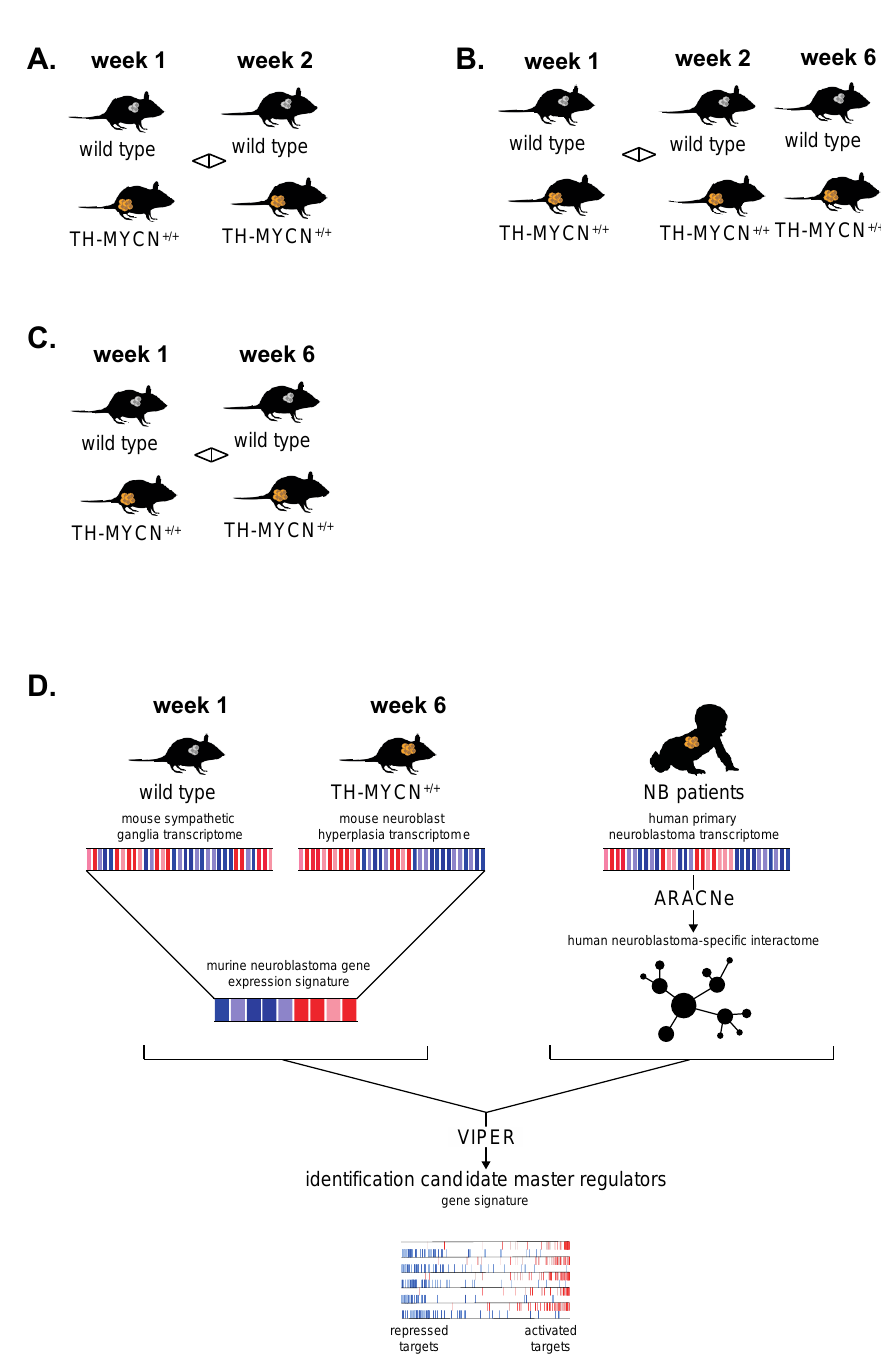
Figure 2. Graphical overview of the different transcriptome analyses performed in this study. Analysis ( A ) focuses on the identification of genes significantly differentially expressed between wild type and TH-MYCN +/+ from weeks 1 to 2 but not through week 6 after birth. Analysis ( B ) focuses on the identification of genes significantly differentially expressed between wild type and TH-MYCN +/+ from weeks 1 to 2 AND through week 6 after birth. Analysis ( C ) focuses on the identification of genes significantly differentially expressed between wild type and TH-MYCN +/+ from weeks 1 to 6 but not yet from weeks 1 to 2 after birth. Analysis ( D ) aims to identify putative master regulators of murine TH-MYCN-driven neuroblastoma development through cross-species transcriptome analysis of murine and human MYCN-driven neuroblastoma.